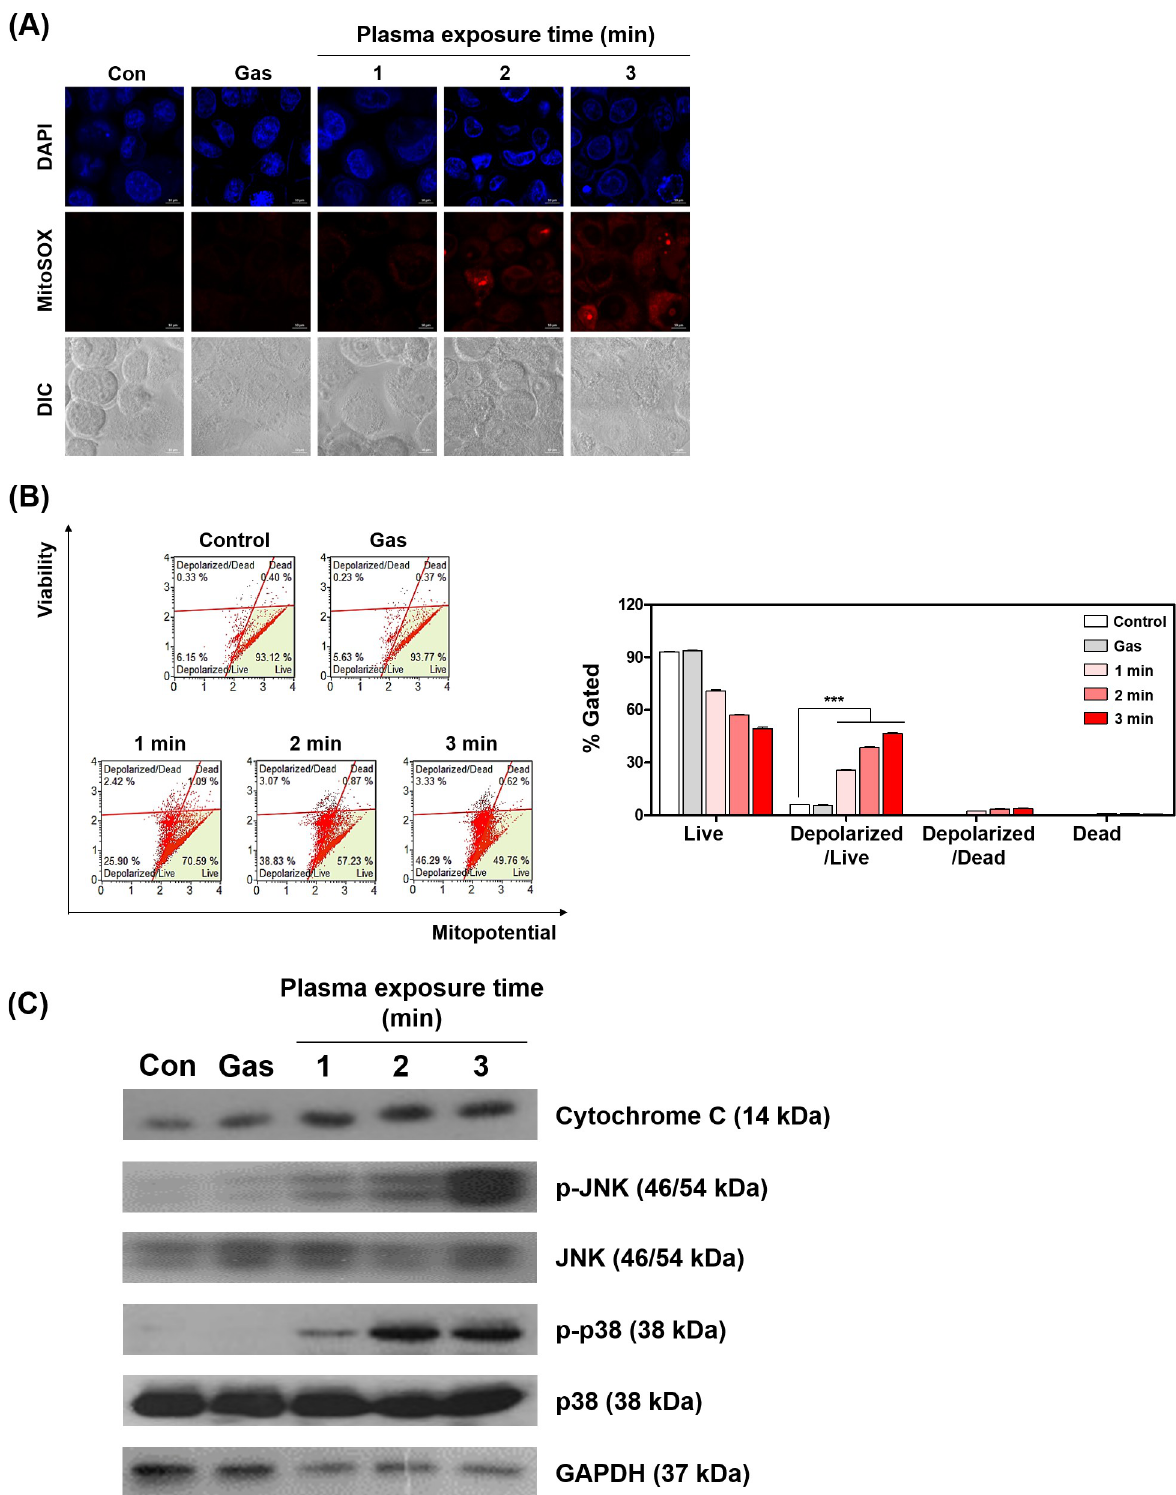
Fig 8. Plasma activated medium (PAM) induces mitochondrial depolarization through upregulating mitochondria ROS. (A) Levels of mitochondrial superoxide was observed by DAPI and MitoSOX fluorescence using confocal microscopy. Representative fluorescence images show the staining of nuclei counterstained with DAPI (blue) and MitoSOX (red). HeLa cells were treated with PAM (pulse width 2.7 μ s, incubation time